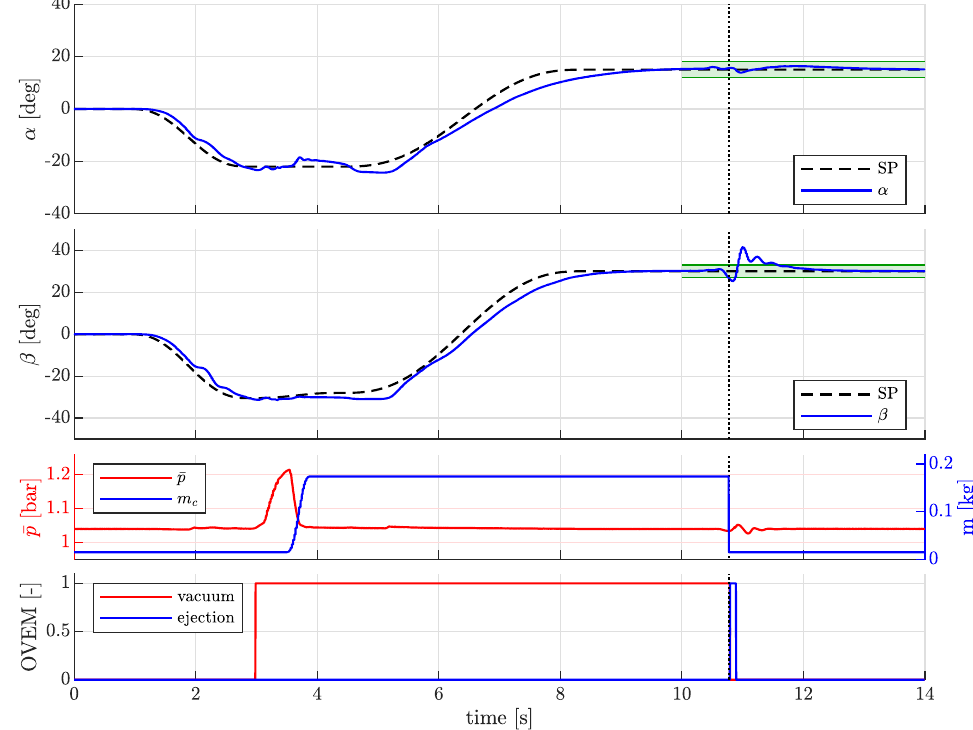
Figure 19. Visualization of the collaborative application where the robot picks up an object and hands it over to a human: The top two plots show the angles α and β and their setpoints, respectively. The third plot shows the lower actuator pressure level and the assumed payload mass. The bottom plot indicates the control inputs of the vacuum generation unit. The arm starts from the idle position, ( α , β ) = ( 0°,0° ) , picks up the object at the initial location, ( − 22°, − 30.5° ) , moves it to the final position at ( 15°,30° ) , and waits for the human interaction. The robot arm maintains the vacuum as long as the object lies in the green region corresponds to an angular range of ± 3° of the setpoint in α or β , respectively. As soon as the human moves the object outside the green region (the time instance is indicated by the vertical, dotted black line), the payload mass assumed by the controller is adjusted, the vacuum is released and the ejection impulse is activated for 0.1s to purge the vacuum. A human interaction is only expected for t ≥ 10s to exclude a triggering of the release condition due to transient tracking